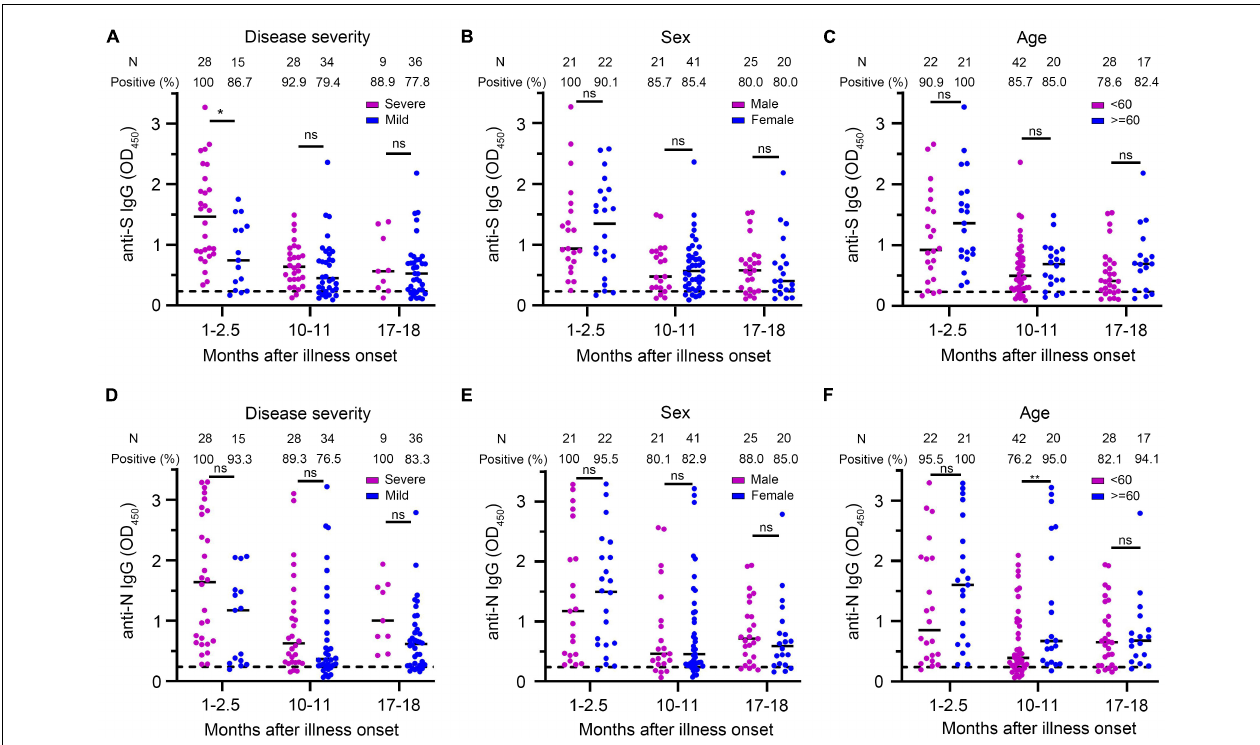
FIGURE 5 | Comparison of anti-S IgG and anti-N IgG levels in different groups of patients. (A–C) Anti-S IgG levels of COVID-19 patients at different times after illness onset according to the severity of the disease (A) , sex (B) , and age (C) . (D–F) Anti-N IgG levels of COVID-19 patients at different times after illness onset according to the severity of the disease (D) , sex (E) , and age (F) . Bars represent the medium. Dotted lines represent the threshold for positive in these assays. Multivariate generalized linear models were used to compare the difference between antibody levels and potential factors (i.e., disease severity, sex, and age). * p < 0.05; ** p < 0.01; ns, not significant; N,